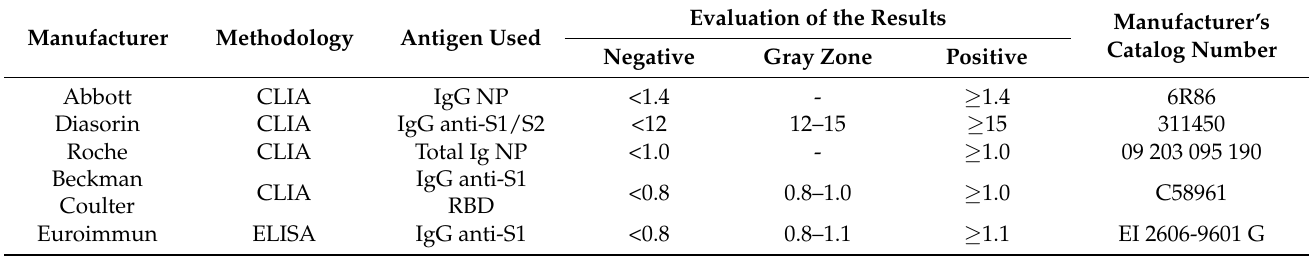
Table 2. Immunoassays of SARS-CoV-2 antibodies used in the